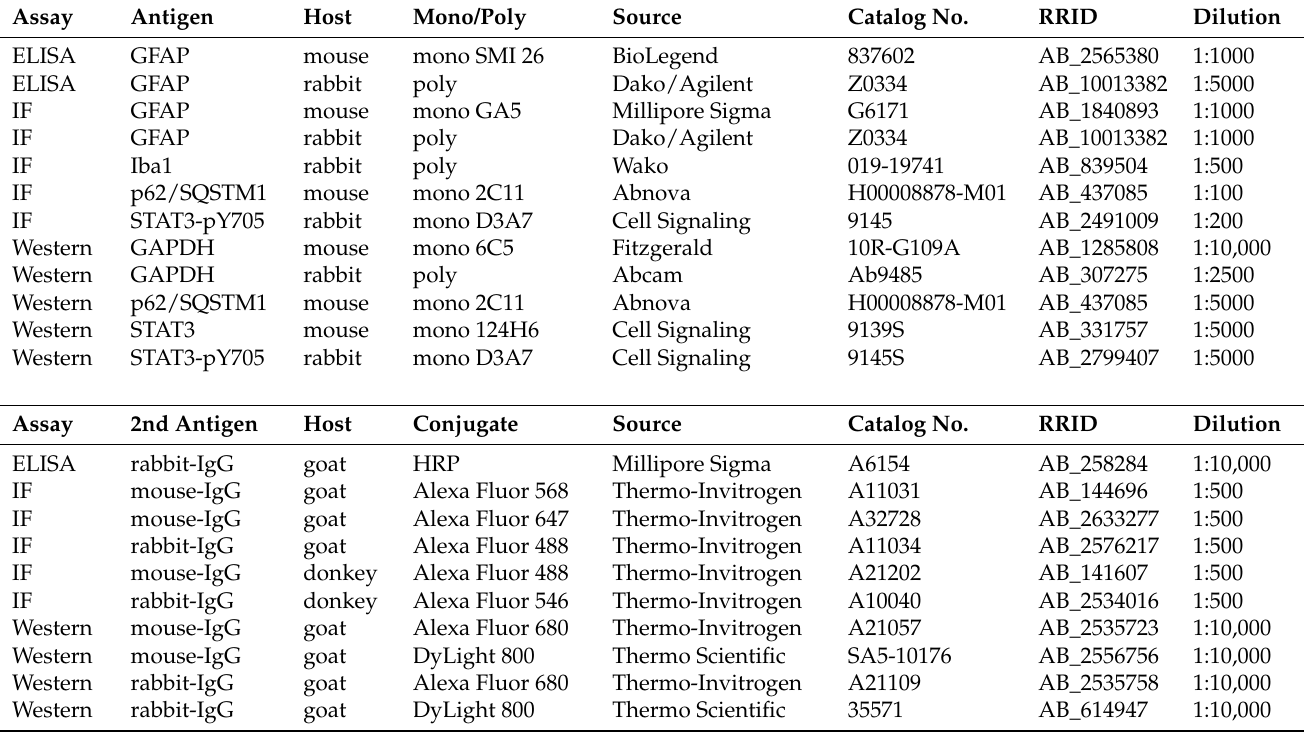
Table 2. Antibodies used in